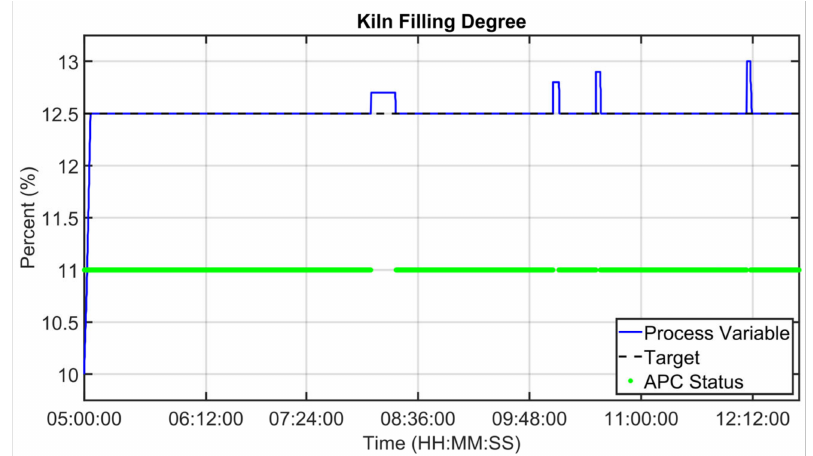
Figure 23. Rotary kiln APC system: field results (kiln filling degree CV).